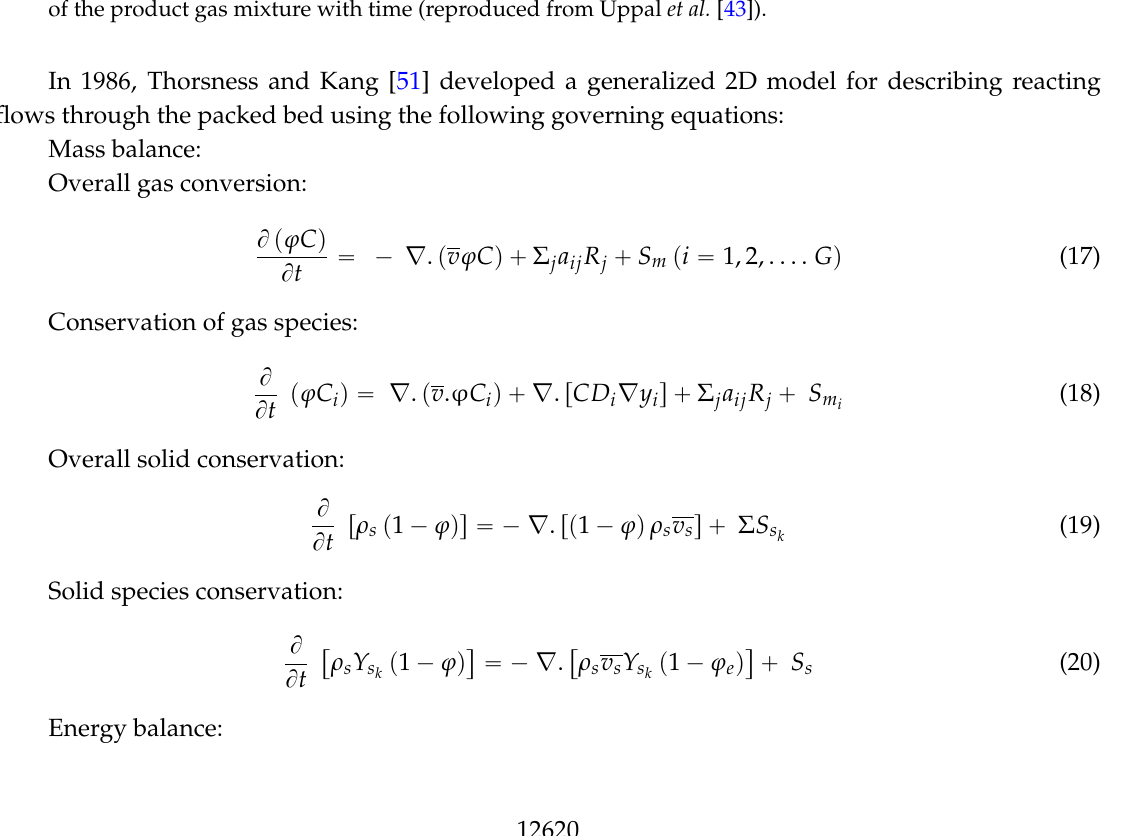
Figure 11. Experimental and simulated ( a ) heating values and ( b ) mole fractions of important gases of the product gas mixture with time (reproduced from Uppal et al.